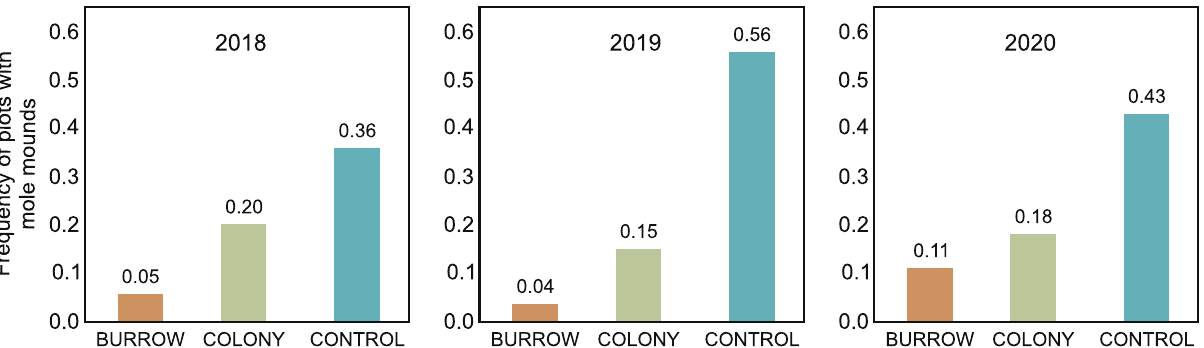
Figure 6. Frequency of plots with mole mounds in the three studied zones presented separately for each year of the study. In each graph: BURROW—plots around the souslik burrow, COLONY—plots in the area of the souslik colony (determined by KDE95%) without taking into account areas near the burrows, CONTROL— plots located outside the souslik colony within the remaining area of the studied grassland (for details see the methods). In a pairwise comparison of the frequency of mole mounds, all differences were statistically significant (p < 0.05) in each year of the study, except from BURROW-COLONY in 2020. The figure was generated in SPSS v24.0 (https:// www. ibm. com/ produ cts/ spss- stati stics) and CorelDRAW Standard 2020 (https:// www. corel.